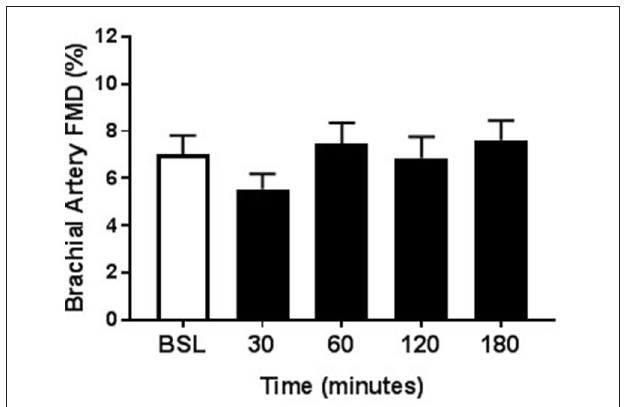
FIGURE 4 | Repeated measures of Brachial Artery FMD. As time control, a subset of participants ( n = 13) underwent the same protocol as the HSM and HFMM trials except they were given 12 oz. water. Brachial artery FMD responses at baseline, and 30, 60, 120, and 180min post-ingestion are shown here. All data presented as mean ±